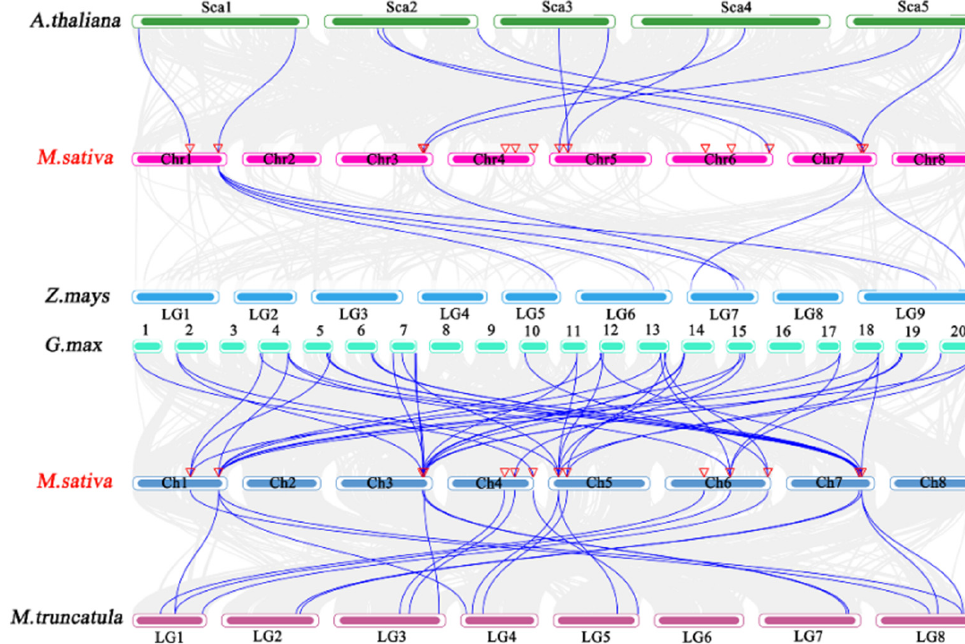
Figure 7. Synthetic analysis of the M. sativa genome with the genomes of one monocotyledon and three dicotyledon plants. Gray lines represent alignment blocks between paired genomes, and blue lines indicate synthetic HSF gene pairs.